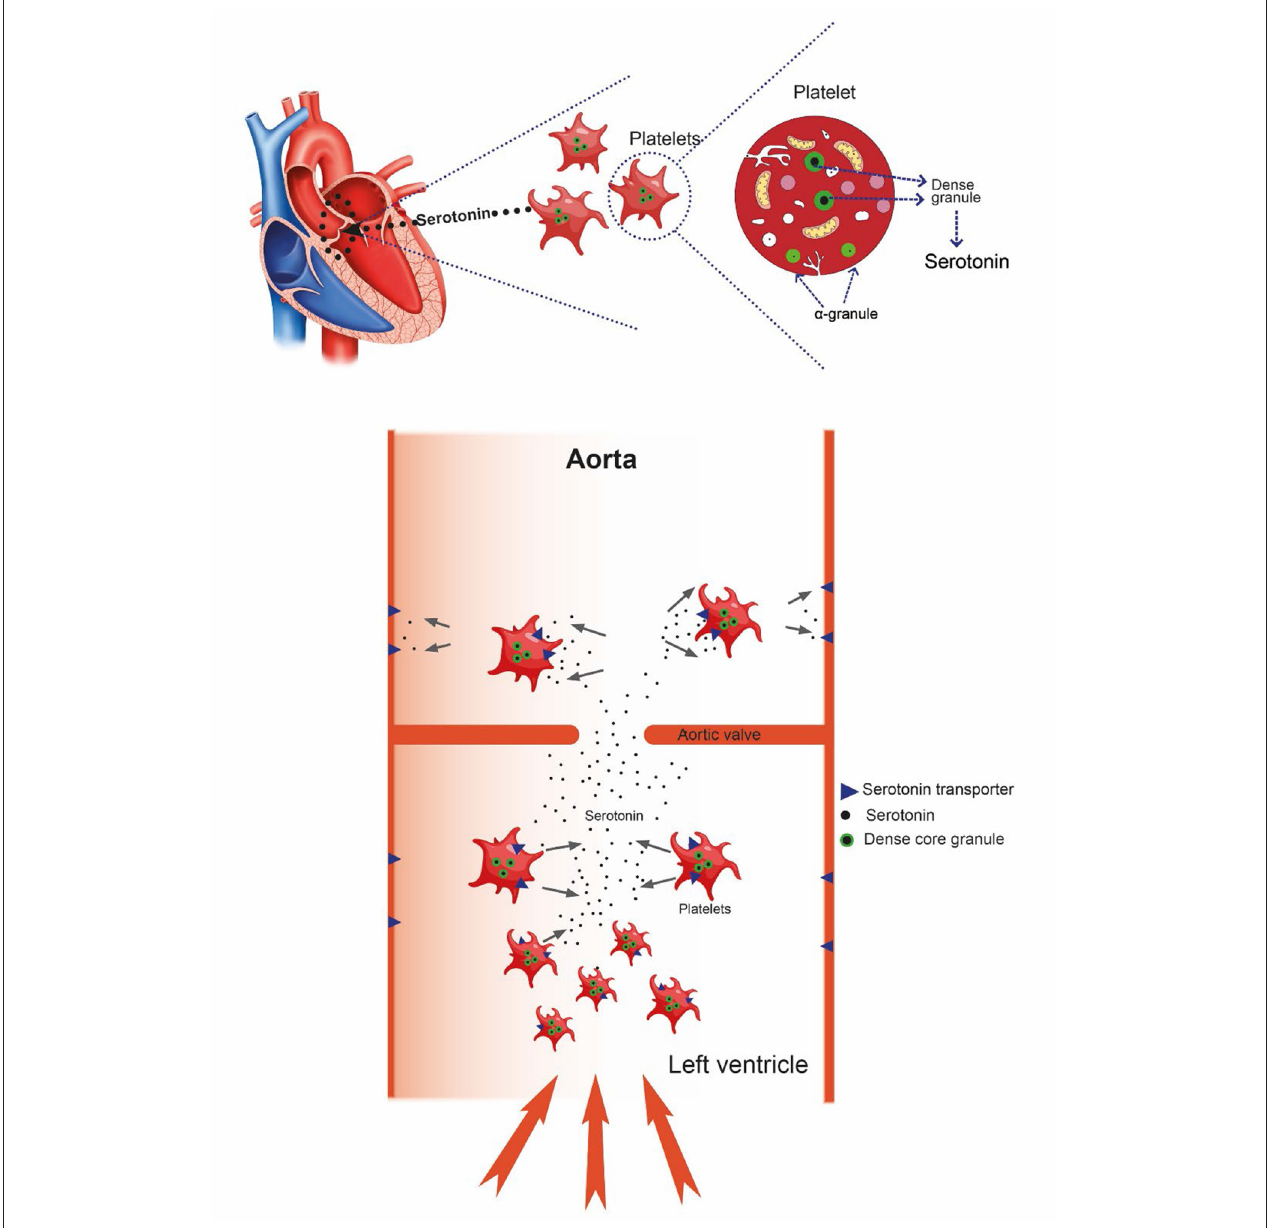
FIGURE 1 | With increased flow velocity and pressure at the aortic valve, platelets may be damaged causing release of serotonin resulting in progressive damage to the valve itself. After passing the valve, serotonin is taken up by the serotonin transporter (SERT), restoring very low serotonin